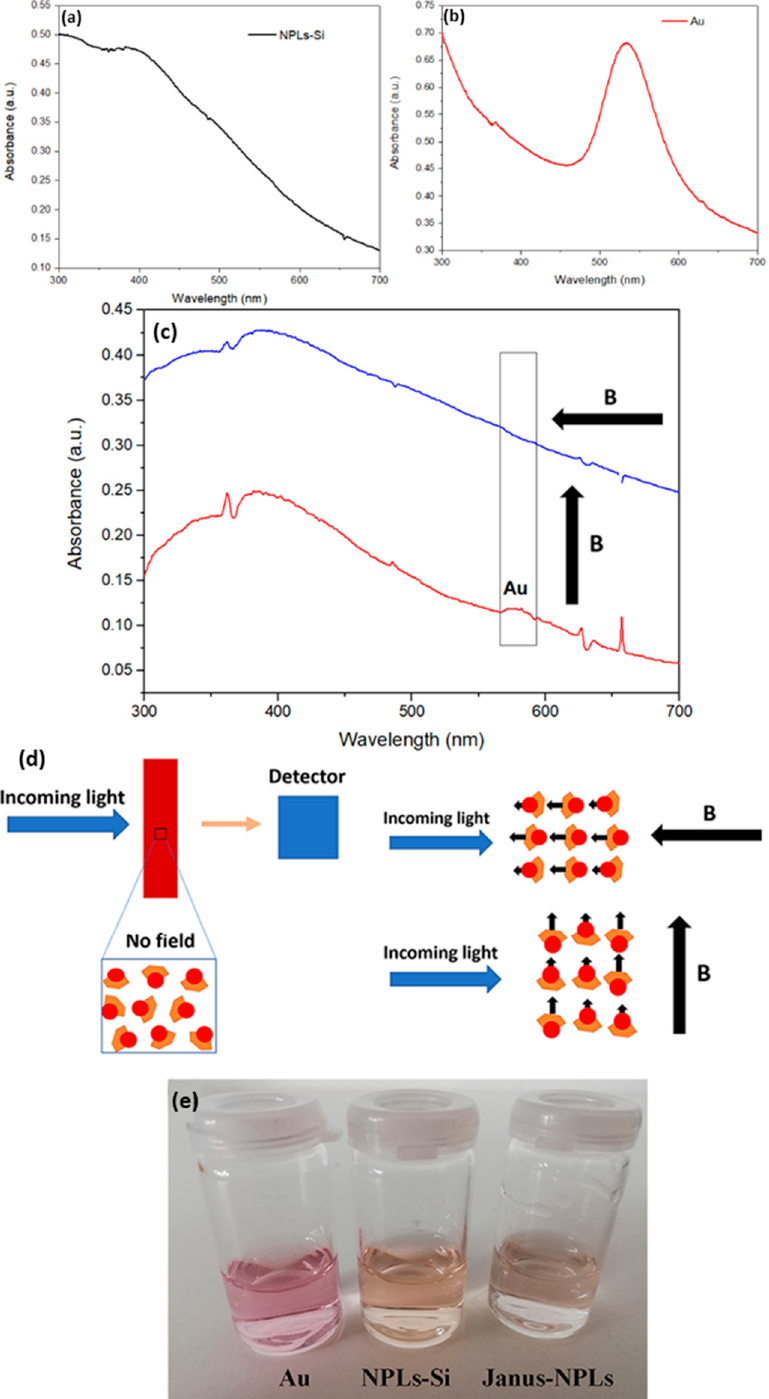
Figure 9. UV-Vis spectra of ( a ) NPLs-Si and ( b ) Au nanospheres; ( c ) UV-vis spectra of Janus NPLs in the presence of parallel (blue line) and perpendicular (red line) magnetic fields; ( d ) Scheme of UV-vis measurement with non-polarized light and applied magnetic field, parallel or perpendicular to the direction of the incident light; ( e ) photograph of aqueous suspensions of Au nanoparticles, NPLs-Si, and Janus NPLs.